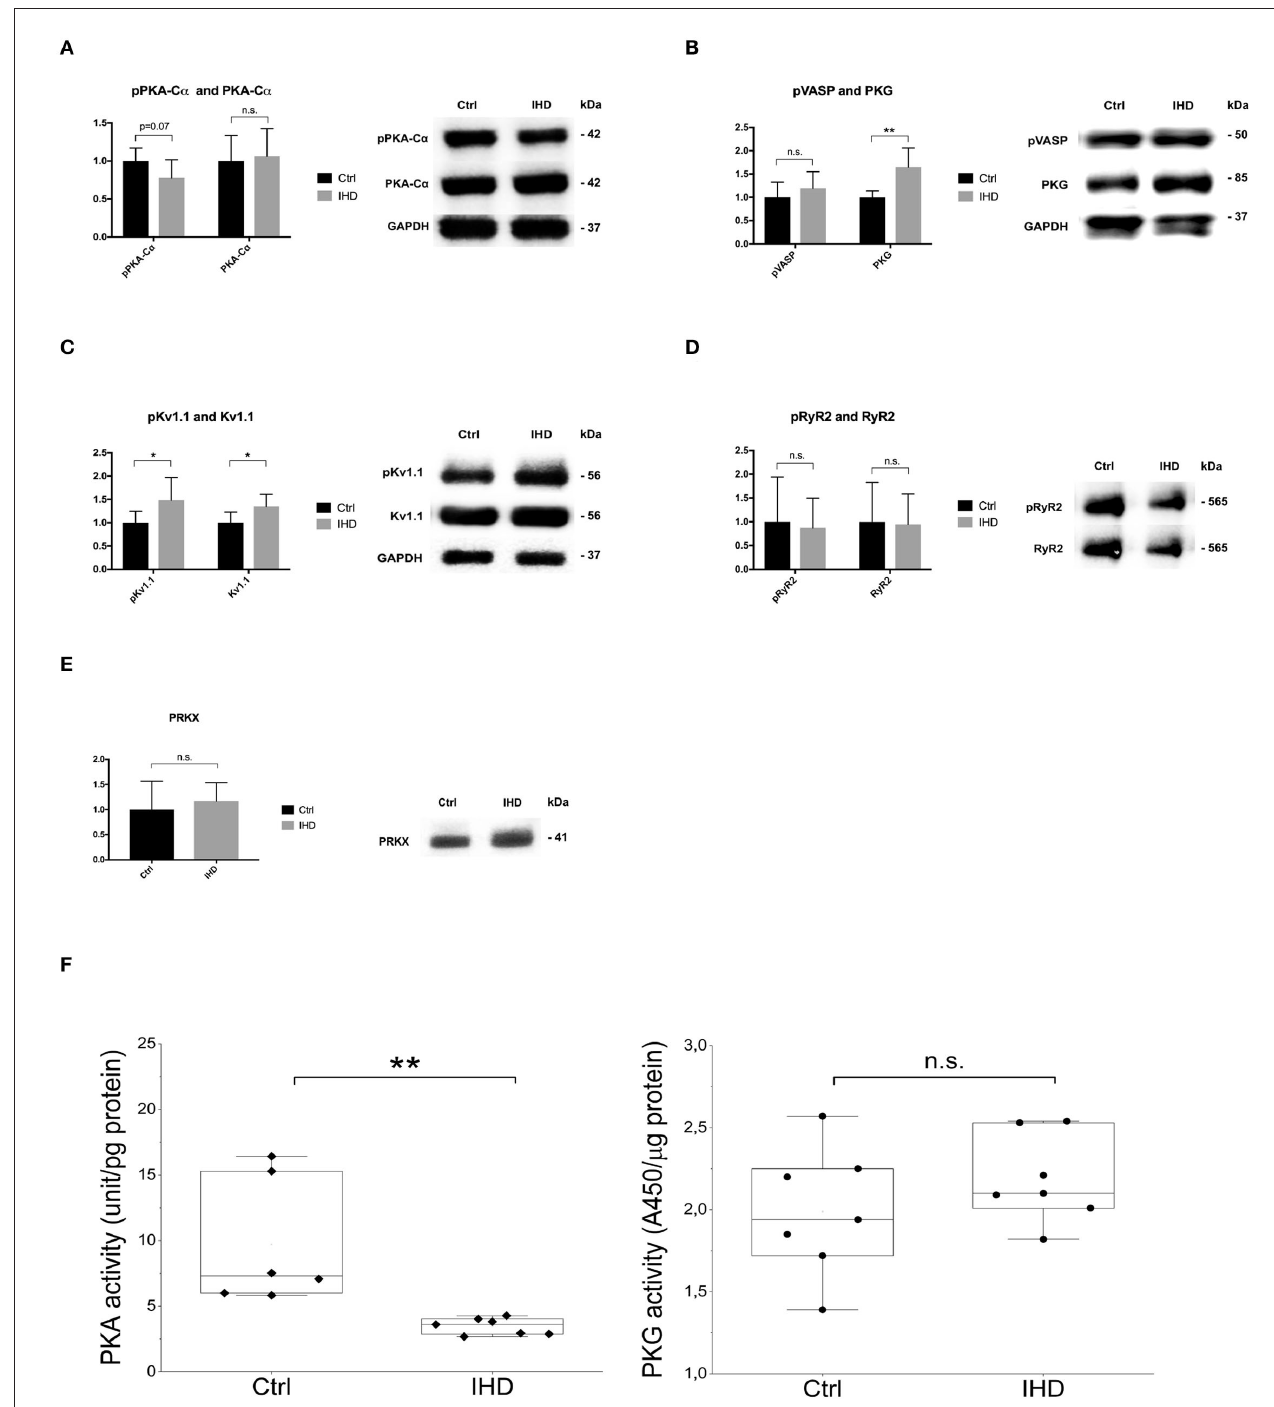
FIGURE 3 | Western blotting and PKA/PKG activity analysis. (A) PKA-C α and phosphorylated PKA-C α (Thr197). (B) PKG1 α and β isoenzymes and phosphorylated downstream target VASP (Ser239). (C) Potassium channel Kv1.1 and phosphorylated Kv1.1. (D) Ryanodine receptor 2 (RyR2) and phosphorylated RyR2. (E) cAMP-dependent protein kinase catalytic subunit PRKX. (F) PKA and PKG activity assay. (A–E) Total protein loading per lane was used to normalize the sample loading variation (IHD n = 7, Ctrl n = 7). The error bars represent standard deviation (SD). Only a representative Western blot, from Ctrl and IHD respectively, was presented. (F) PKA (IHD n = 7, Ctrl n = 6) and PKG (IHD n = 7, Ctrl n = 7) assays were performed in duplicate from 2 different dilution preparations. Statistical analysis was made by T tests (and non-parametric tests) in Prism software for Western blotting and Mann-Whitney U test for PKA and PKG activity assay. n.s., not significant, * p < 0.05, ** p <